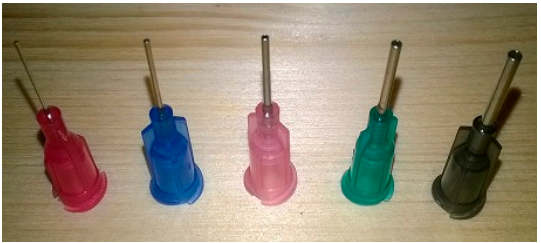
Figure 4. Various nozzle dimensions, from 0.15 mm to 1.54 mm.